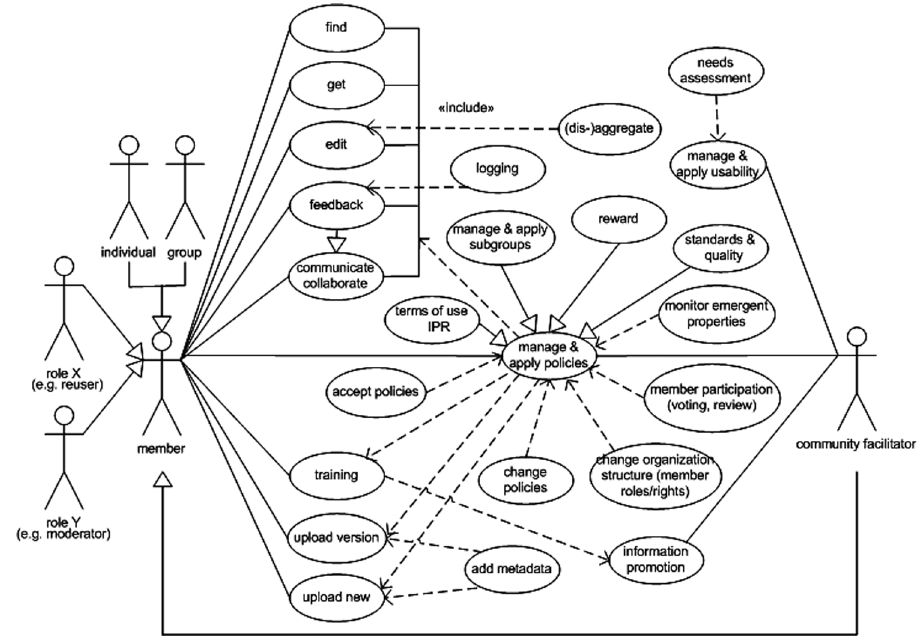
Figure 1. Use cases in a learning object exchange community (UML use case diagram, all dotted lines are <<include>>